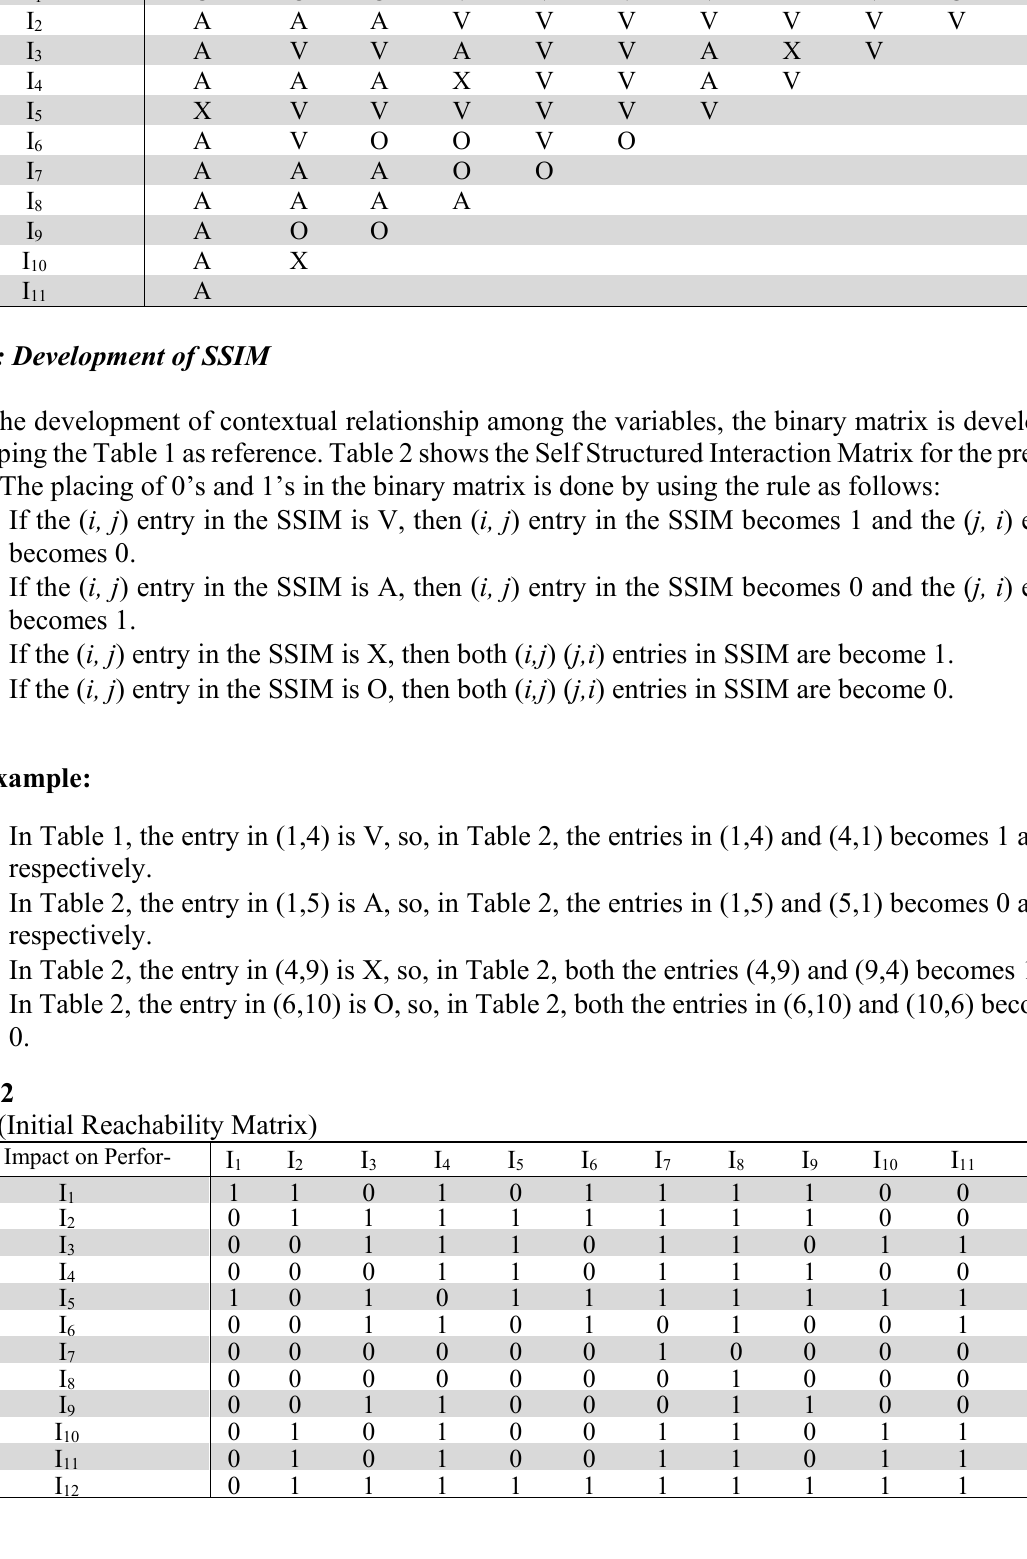
Contextual relationship among lean principles impact in an organization LM Impact on Performance